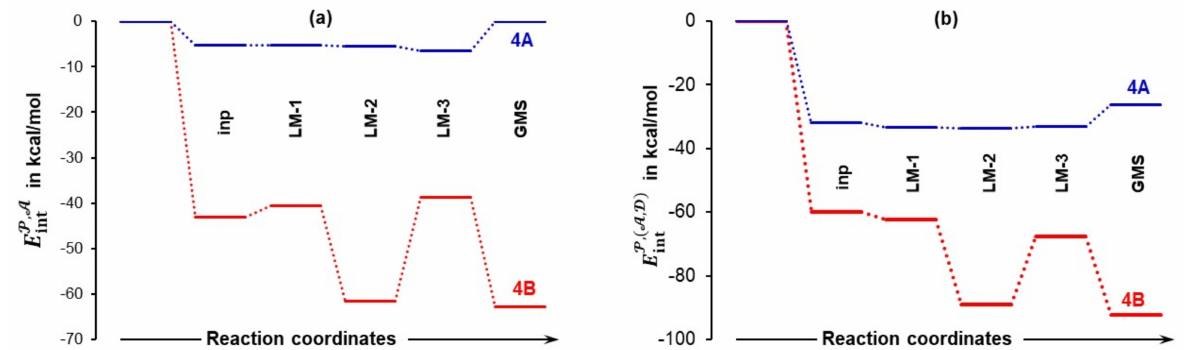
Figure 10. Trends in the interaction energies between molecular fragments: P and A in part ( a ) and P and ( A plus D ) in part ( b ). They were computed for the indicated 4A and 4B